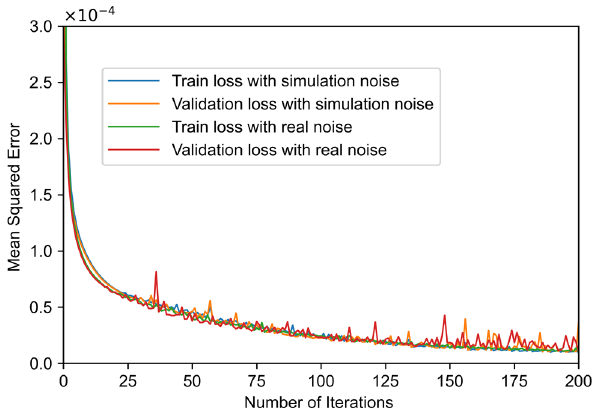
Figure 6. Variation of the mean square error with the number of iterations for training with simulated noise and real noise.